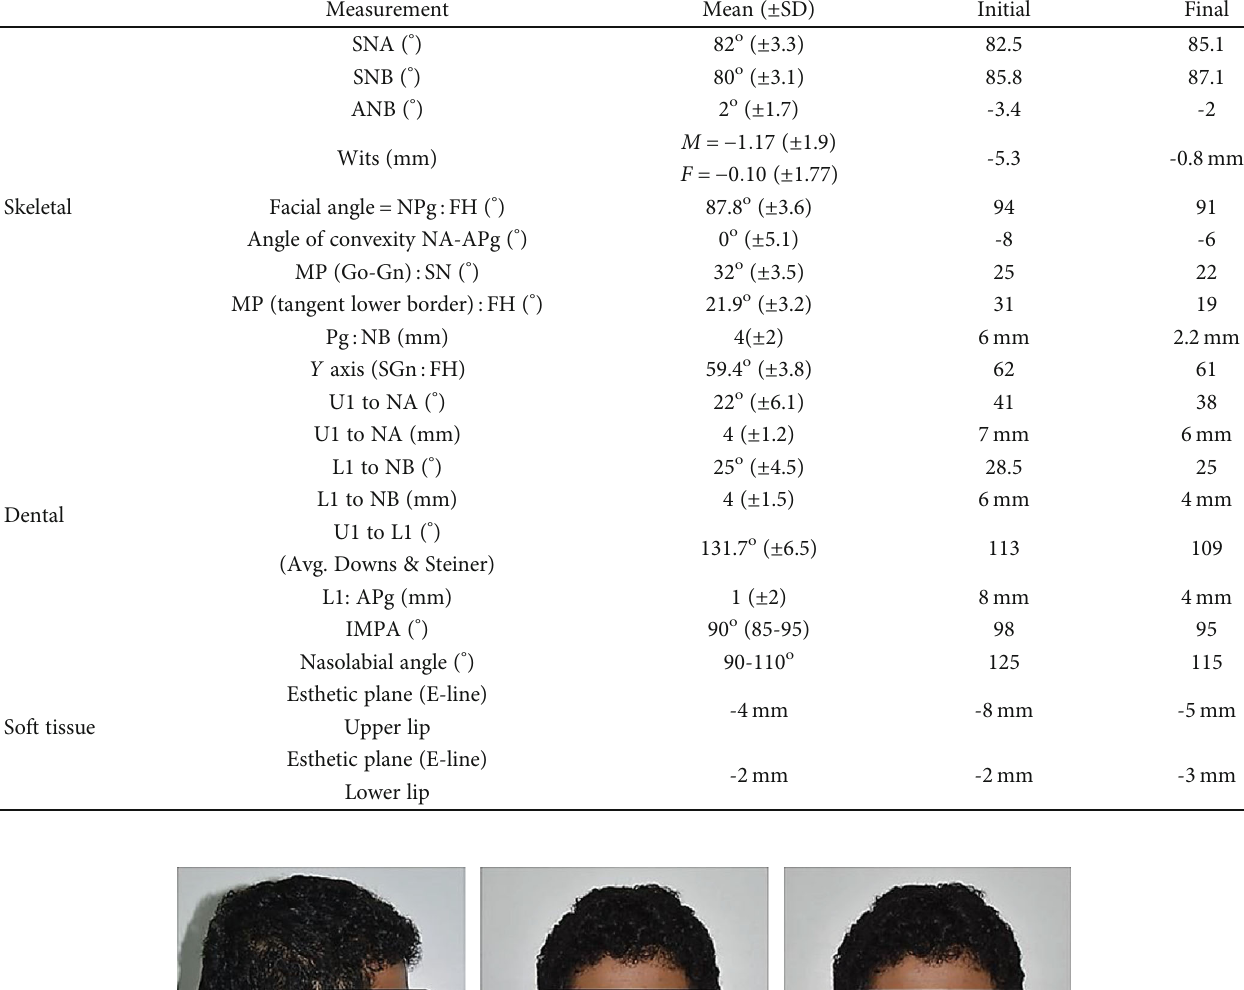
Table 1: Cephalometric analysis.